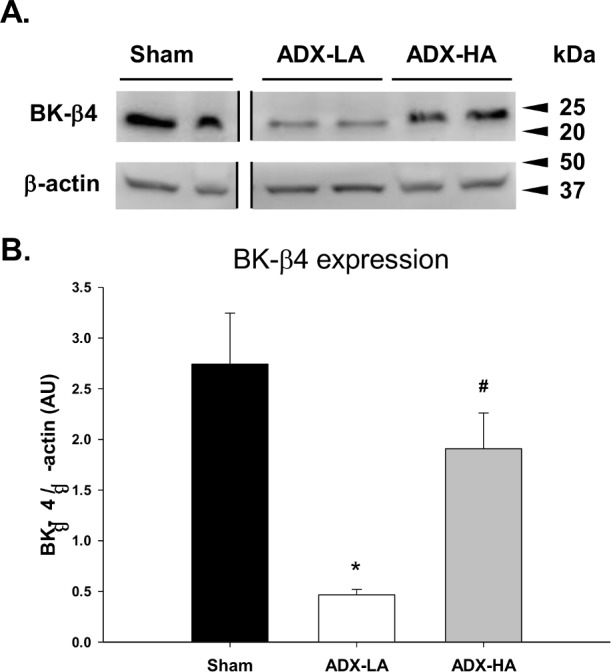
The effect of aldo on BK-β4 expression of LNaHK mice.Western blot representative immunoblots (A) and summary bar plots (B) of BK-β4 expression in kidney cortex of sham, ADX-LA, and ADX-HA mice. β-actin was used as a loading control. * P = 0.004 vs. sham; # P = 0.019 vs. ADX-LA; n = 4. All bands shown were from the same blot.